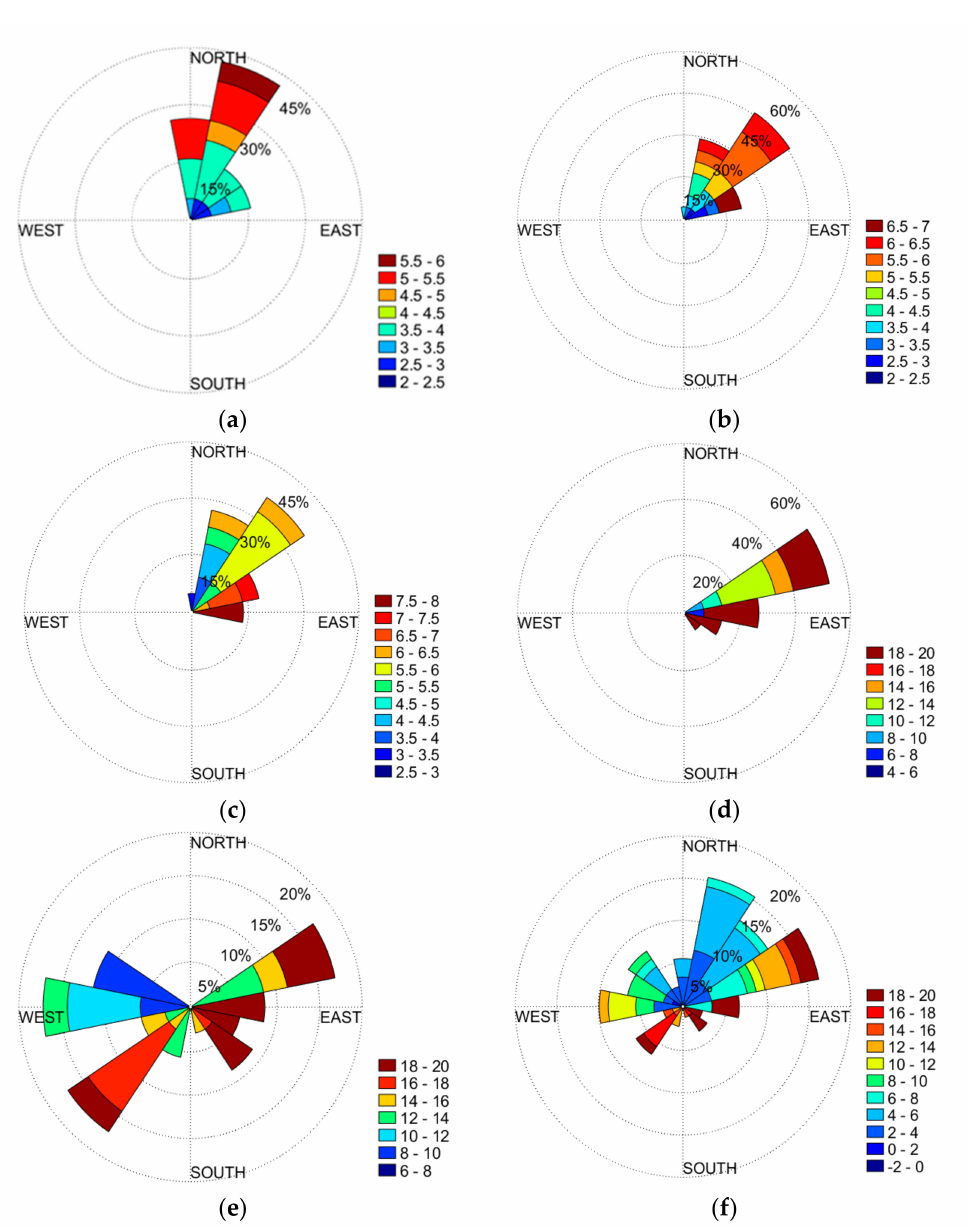
Figure 13. The wind rose during the 29 September to 3 October at the Zhoushan sea area in the special periods: ( a ) the wind direction (WD) (before 0:00 on 30 September); ( b ) the WD in swell dominating period (18:00 on 29 September to 14:00 on 30 September); ( c ) the WD of the period of significant wave height slow increasing (23:00 on 29 September to 20:00 on 30 September); ( d ) the WD of the period of significant wave height rapidly increasing (20:00 on 30 September to 10:00 on 1 October); ( e ) the WD in the wind wave dominating period(23:00 on 30 September to the 8:00 on 2 October); ( f ) the WD from 29 September to 3